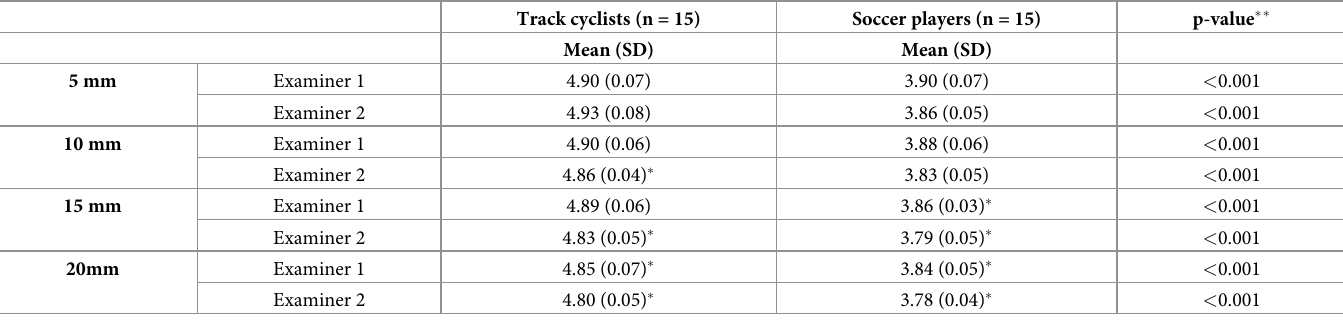
Table 1. Ultrasound measurements for PT thickness (mm) at the four measurement points (5-10-15-20mm).